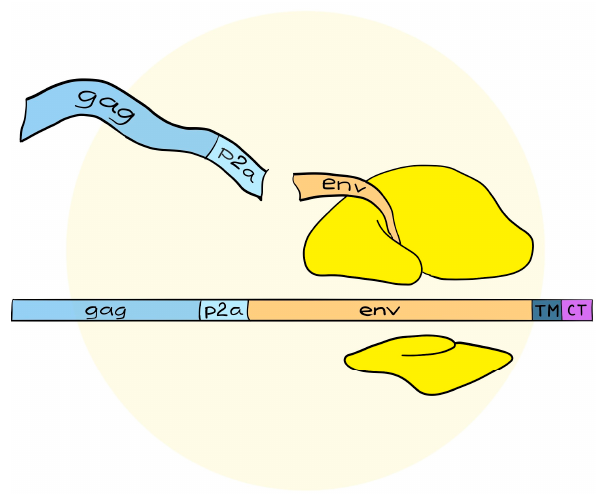
Figure 2. Design of the single frame transgenic cassette in adenoviral VLVs. The viral VLP-forming Gag protein is synthesized in-frame with the Env antigen, but separated with a self-cleavable peptide. This produces Gag and Env or any other downstream antigen in a 1:1 ratio.